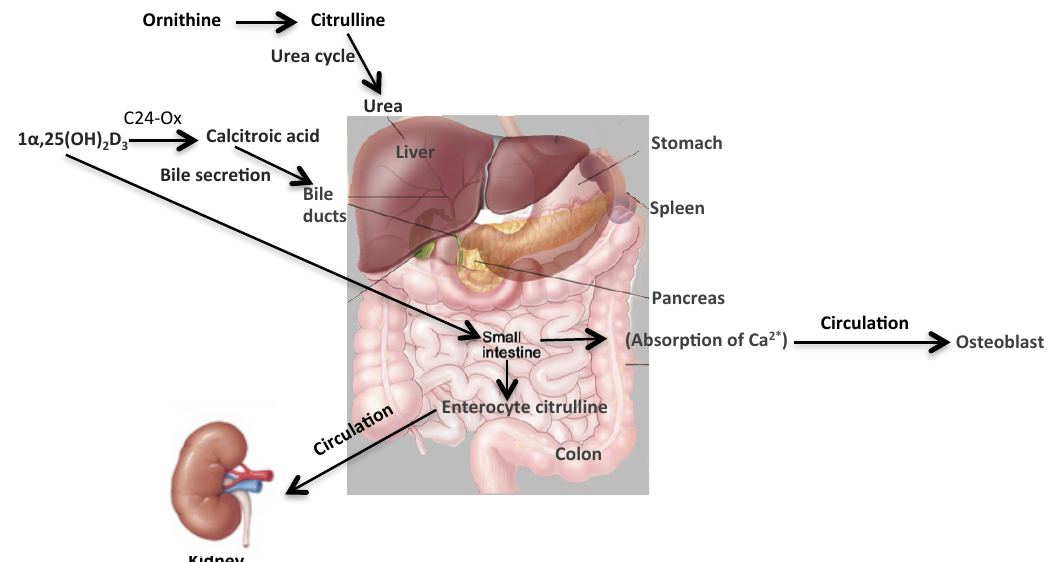
Figure 6. Overall metabolism of citrulline in the urea cycle and of calcitroic acid secretion into the bile. Citrulline is an important intermediate of the urea cycle in the liver and is primarily synthesized from arginine and glutamine in the enterocytes. Citrulline is essential for the synthesis of arginine, which in turn produces nitric oxide. On the other hand, calcitroic acid has a less defined biological role. Calcitroic acid is an end product of 1α,25-(OH) 2 D 3 metabolism through a C-24 oxidation by mitochondrial CYP24 enzyme and is secreted into the bile [11]. Osteoblasts, kidneys and intestine metabolize 1α,25-(OH) 2 D 3 through this oxidation pathway, which is an important regulatory pathway for dihydroxyvitamin-D 3